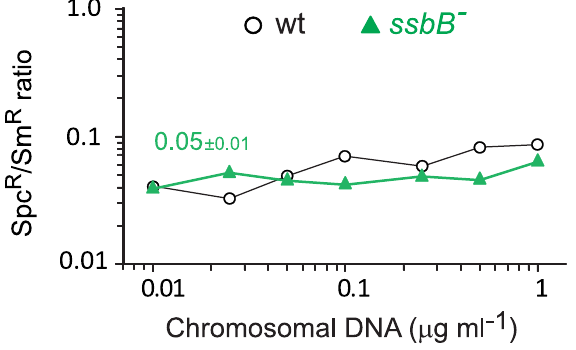
Figure 7. Transformation of a 8,653–nt heterology and a point mutation in wildtype and ssbB 2 cells. Ratio between the number of Spc R (long heterology) and Sm R (point mutation) transformants in strains R3055 ( ssbB 2 ) mutant and R1818 (wild type), calculated from data in Figure S4A and S4B).